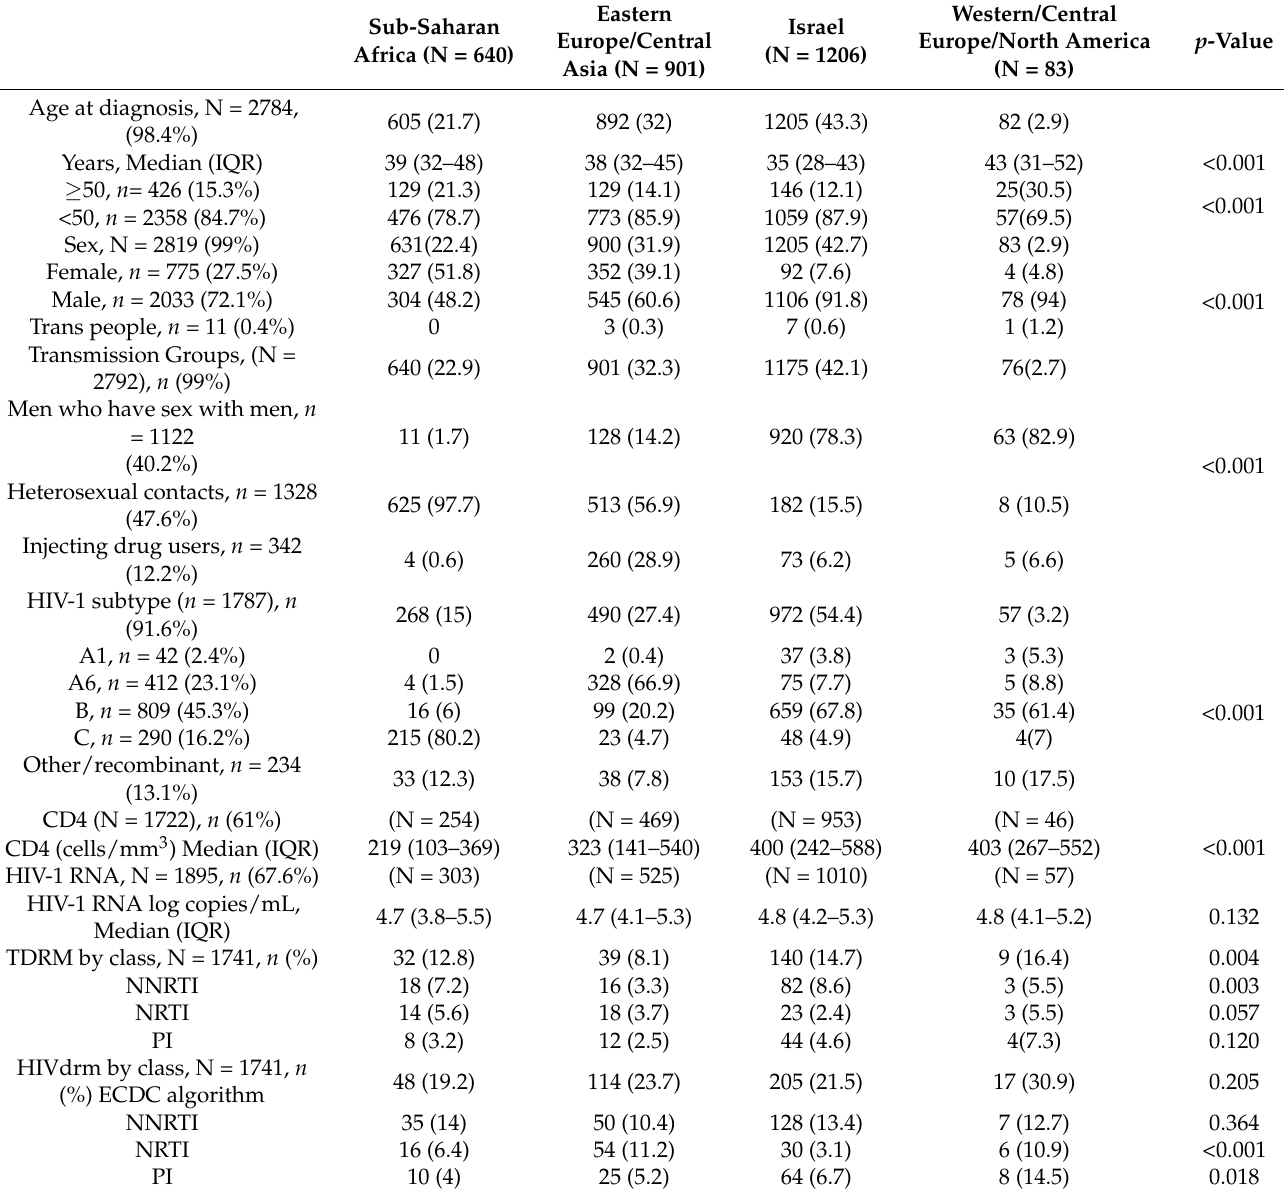
Table 2. Characteristics of newly diagnosed PLHIV (2010–2018) with known * place of birth ( n = 2830).